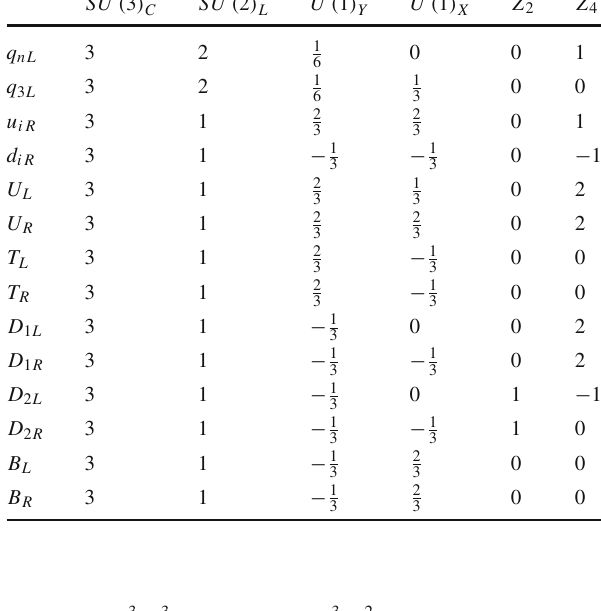
Table 2 Quark assignments under SU ( 3 ) C × SU ( 2 ) L × U ( 1 ) Y × U ( 1 ) X × Z 2 × Z 4 . Here i = 1 , 2 , 3